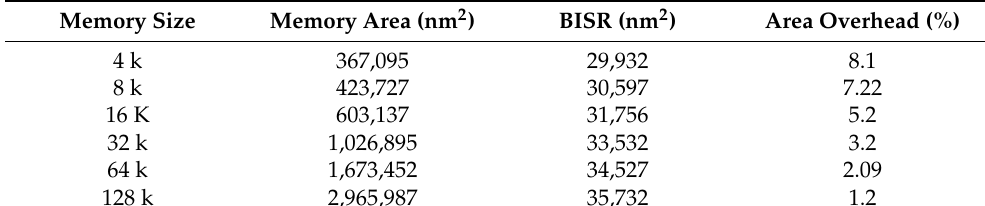
Table 10. Various memory models versus BISR area.